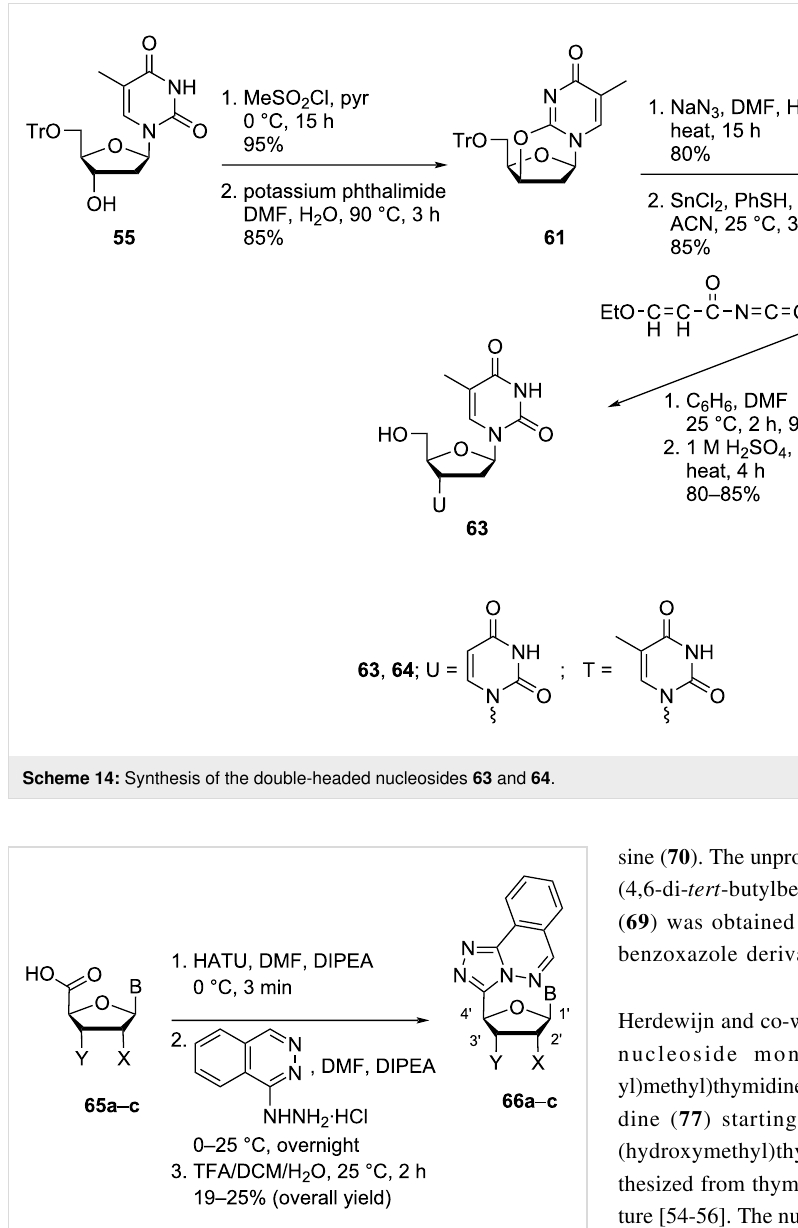
Timoshchuk and Hogrefe [12] have synthesized the double- headed nucleosides ( R )- N 1 -(4-(4,6-di- tert -butylbenzoxazol-2-